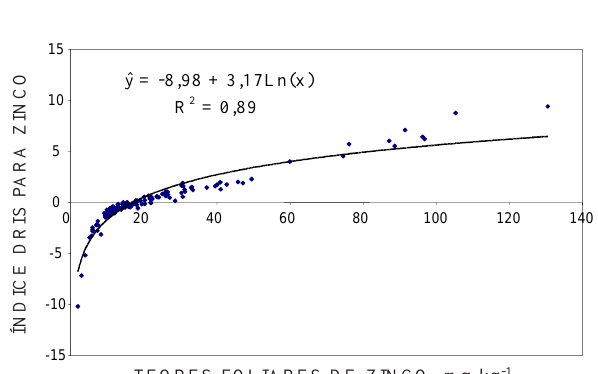
Figura 2. Índices DRIS para zinco, considerando seus teores foliares de cafeeiros ( C. arabica L.) do sul de Minas